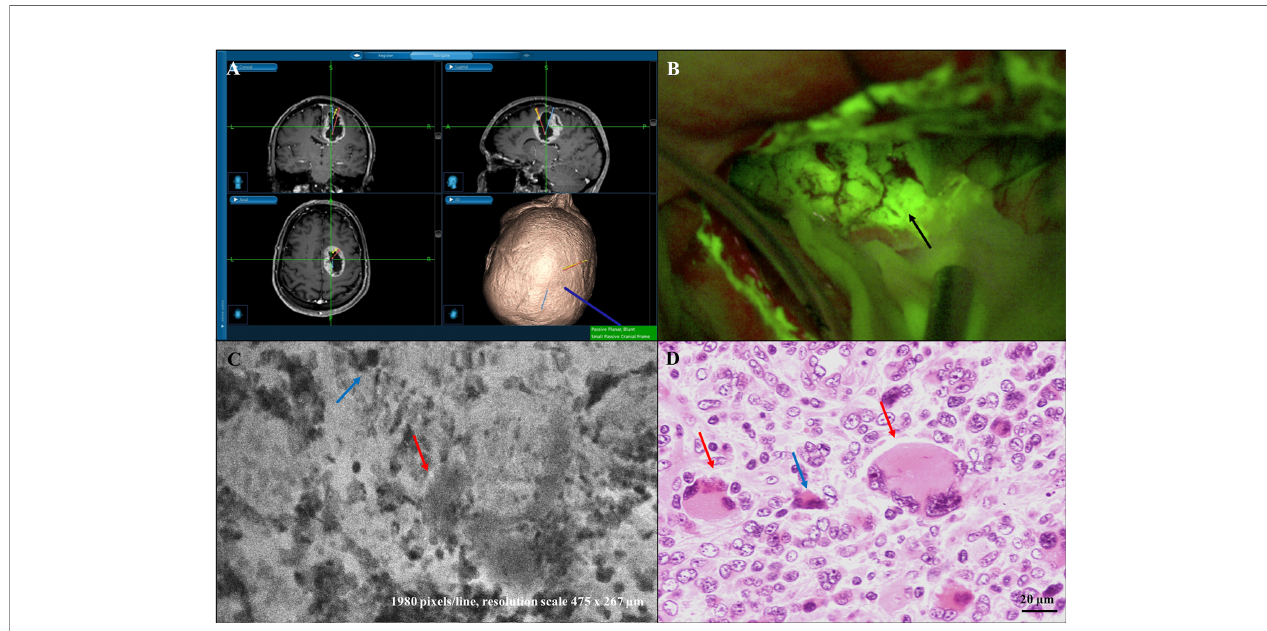
FIGURE 2 | Diagnostic concordant case: right frontal giant-cells GBM (case n. 4). (A) Neuronavigation MR images showing the site of “ A ” biopsy sampling in the GBM core. (B) Intraoperative view during tumor removal with SF-guided technique. Yellowish fl uorescent areas under Y560 fi lter activation of the surgical microscope correspond to tumor tissue (site of “ A ” sampling, black arrow). Both CONVIVO ® ex vivo images (C) and frozen and classical histopathological sections (D) con fi rmed the GBM diagnosis. To note the presence of «giant cells» (red arrows), along with increased cellularity and foci of necrosis with apoptotic cells (blue arrows) in both (C, D) .